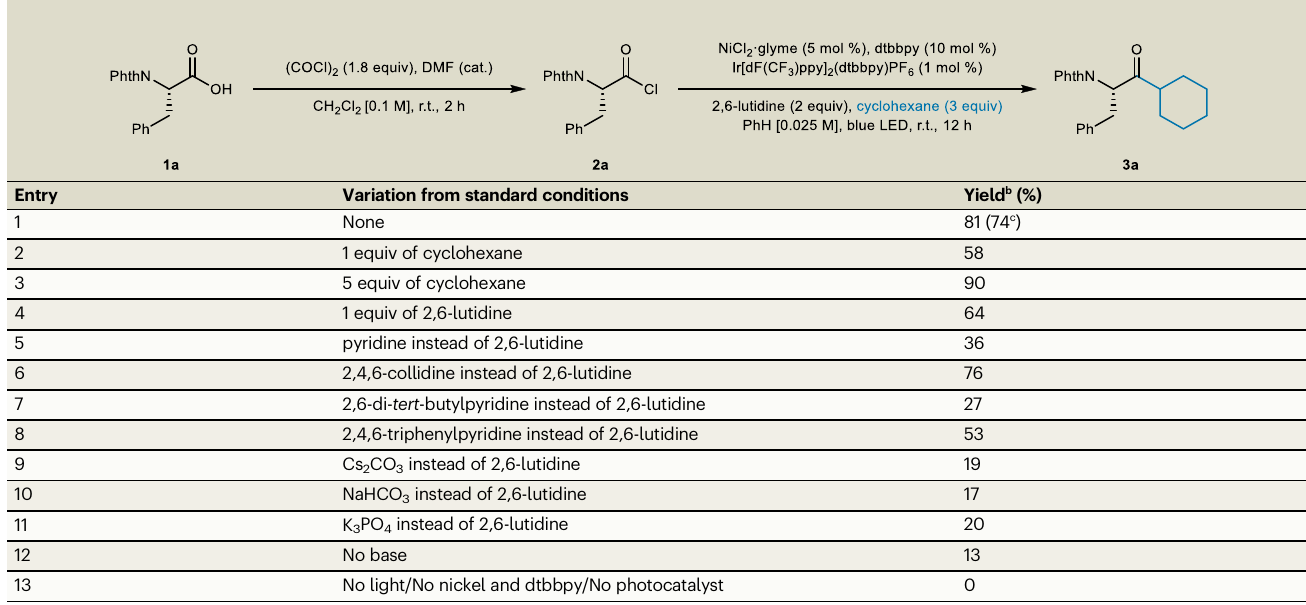
Table 1 | Optimization of reaction conditions